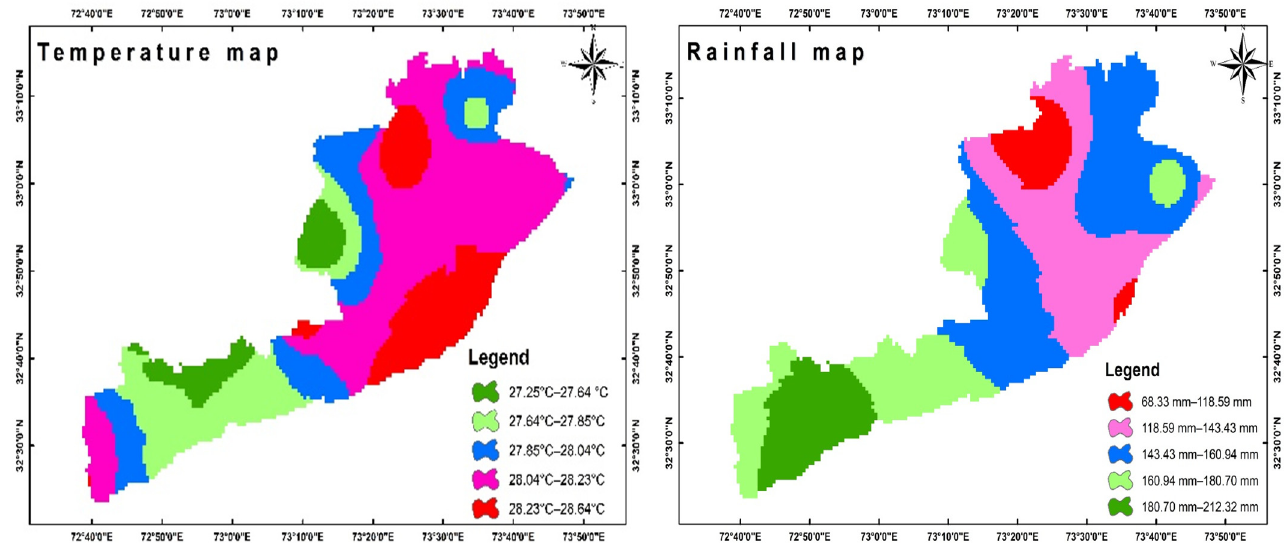
Figure 5. Maps of climate features (rainfall is in millimeters, and temperature is in degrees Celsius) in the research area.